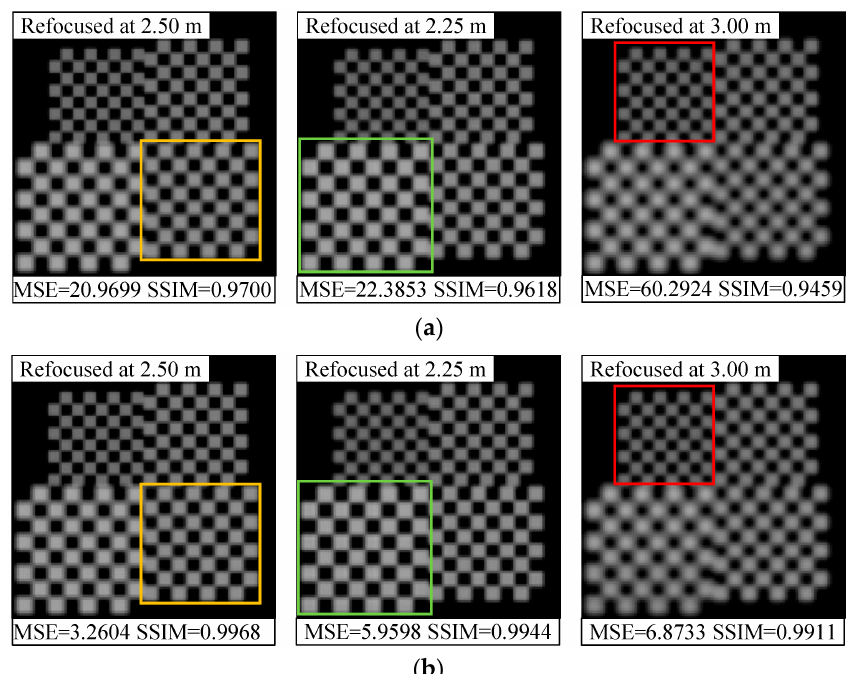
Figure 12. Comparison of refocused images at varying depths for tilt error correction: ( a ) With an error